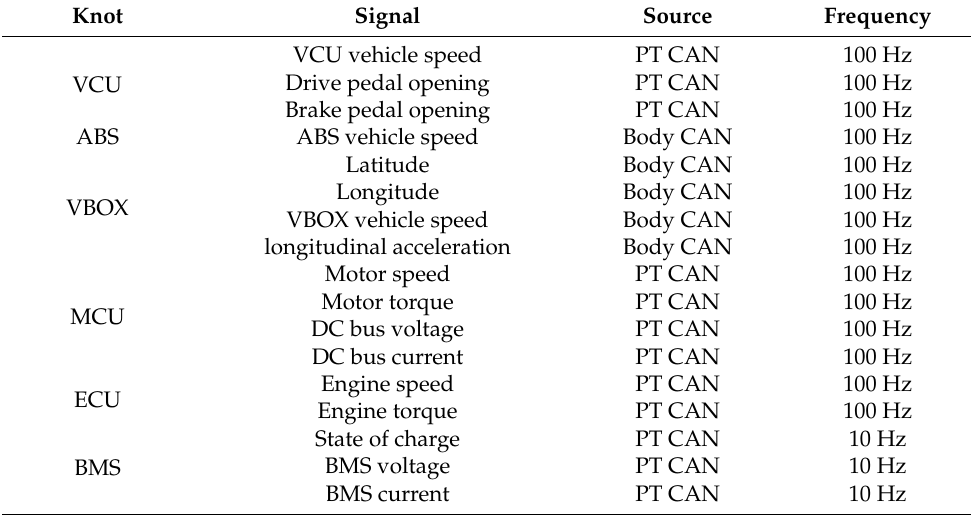
Table 2. The signal